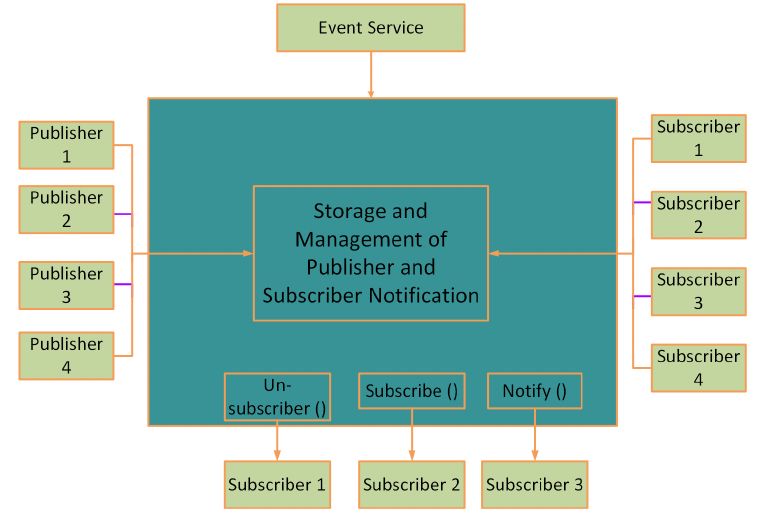
Figure 5. P/S Communication